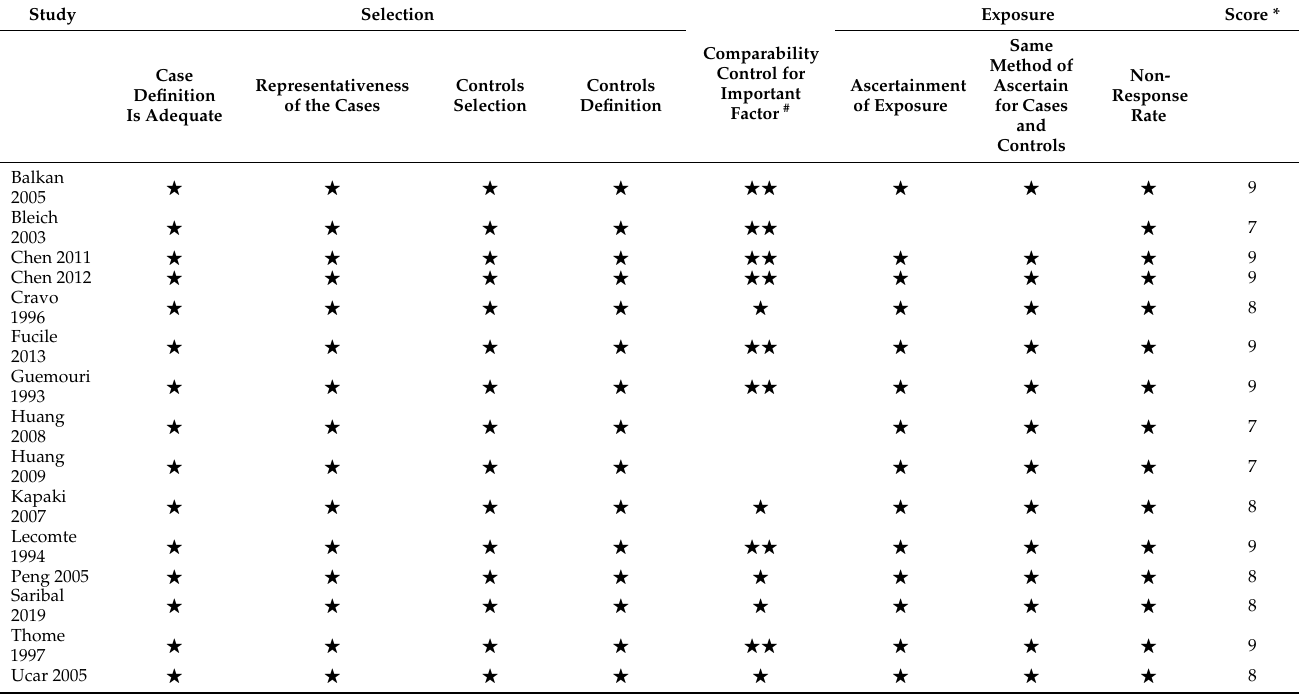
Table 2. Results of quality assessment by using the Newcastle–Ottawa scale for case-control